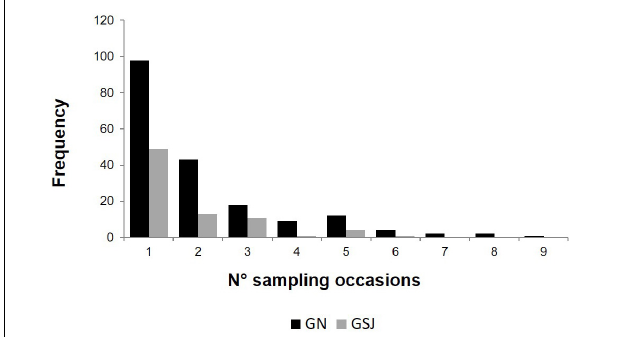
FIGURE 2 | Histogram of dusky dolphin sightings by sampling period in Golfo Nuevo (GN) and Golfo San José (GSJ).